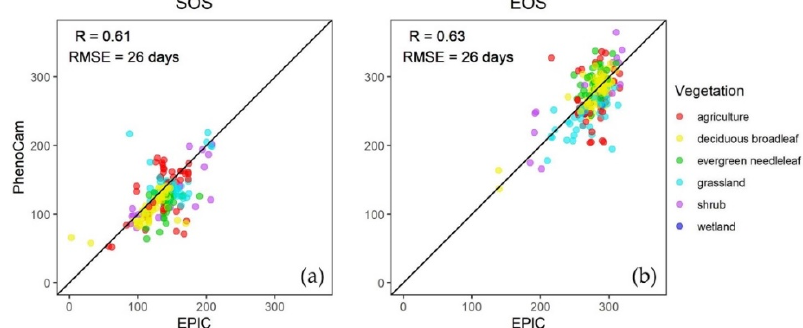
Figure 7. The correlation between MODIS and PhenoCam ( a ) SOS and ( b ) EOS DOY over 2016–2018.